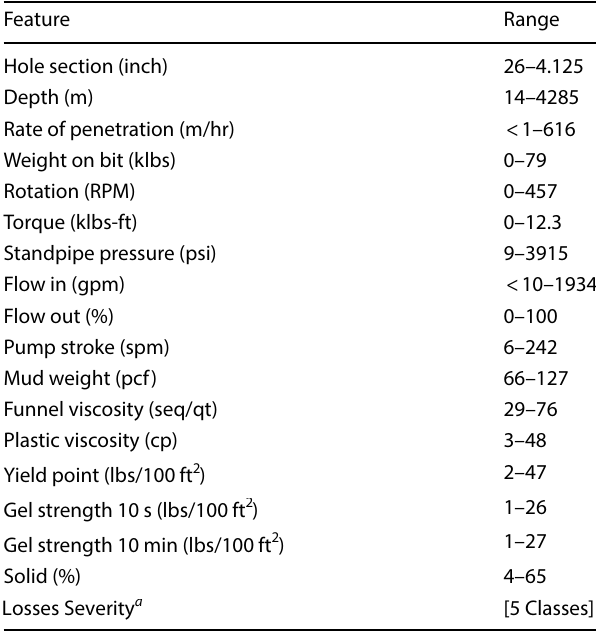
Table 2 Variables and their value ranges for the 65,376 data records compiled for the Azadegan oilfield